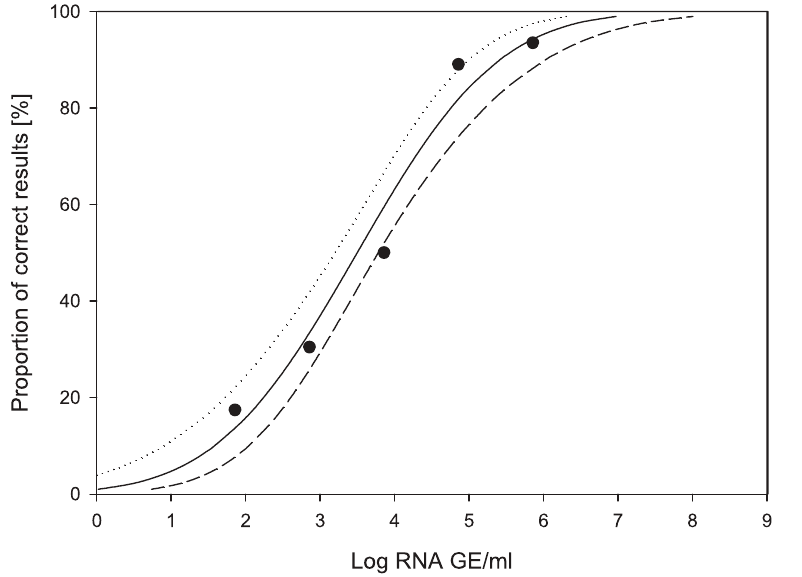
Figure 1. Probit analysis of data sets with a correct result (y axis) for DENV-1 related to viral RNA concentration in positive samples (x axis). Data points represent individual samples in the panel. The thick line is the regression line calculated on the basis of a probit model (dose- response curve), and thin lines are 95% confidence intervals. Data fit into the model with p , 0.003.